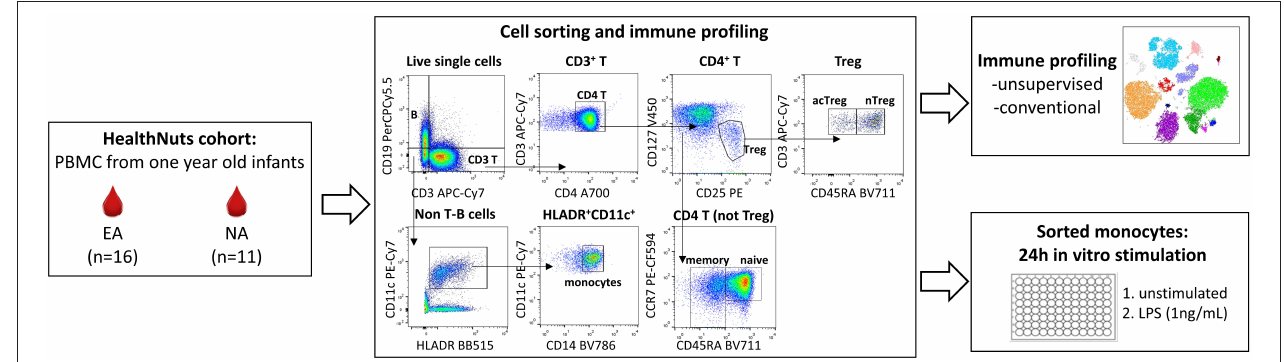
FIGURE 1 | Experimental workflow for immune profiling and monocyte stimulations in 1 year old healthy and food allergic infants. Cryopreserved PBMC from n = 16 egg allergic (EA) and n = 11 non-allergic (NA) 1 year-old infants were thawed and used for multi-parameter fluorescence activated cell sorting (FACS) to explore circulating monocyte and CD4T cell immune cell profiles (analyzed by unsupervised and traditional manual gating), and to purify monocytes for culture experiments. Sorted monocytes underwent a 24h stimulation with media (control) or LPS (1ng/mL).